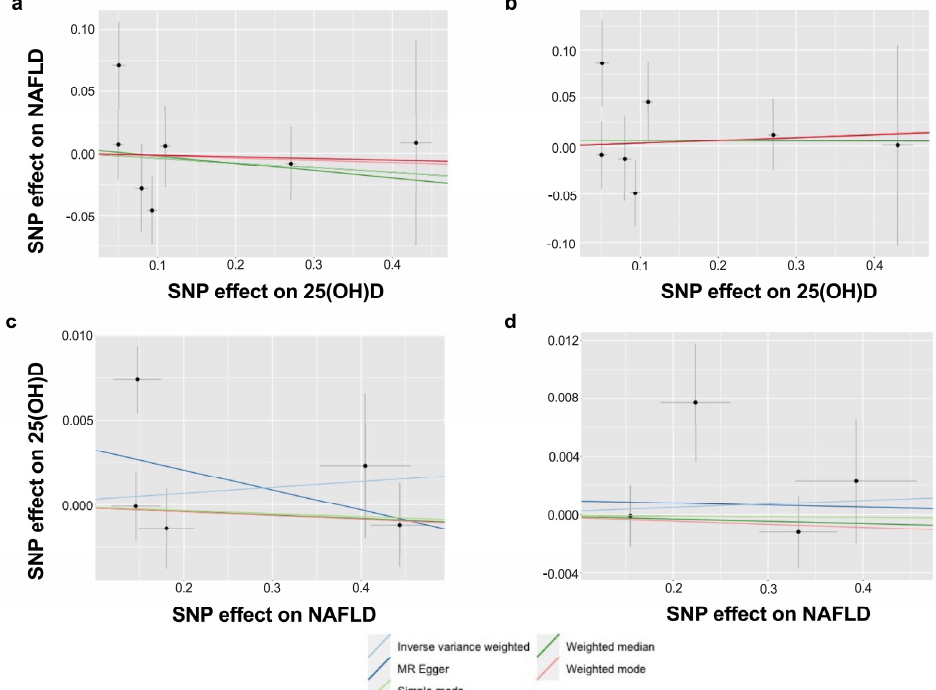
Figure 2. Scatter plots of SNPs associated with 25(OH)D and NAFLD using different MR methods. The genetic associations with circulating 25(OH)D levels against NAFLD risk in the primary analysis ( a ) and sensitivity analysis ( b ). The genetic associations with NAFLD in the primary analysis ( c ) and sensitivity analysis ( d ) against circulating 25(OH)D levels. A cross around each SNP show 95% CI. The slopes of each line represent the causal association for each method. MR, Mendelian randomisation; NAFLD, non-alcoholic fatty liver disease; SNP, single-nucleotide polymorphism.